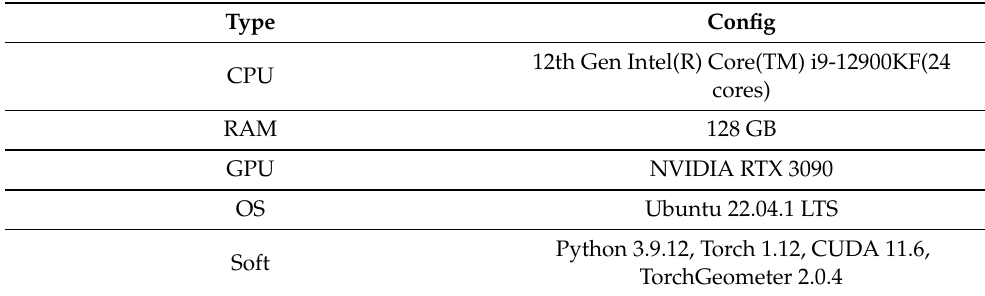
Table 5. Experimental Environment Configure.